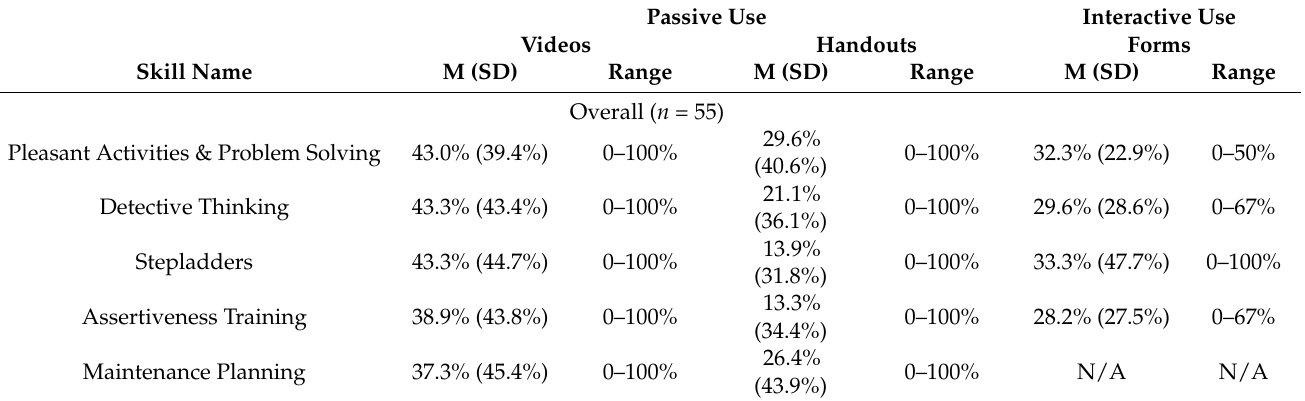
Table 2. Web tool use of ADAPT